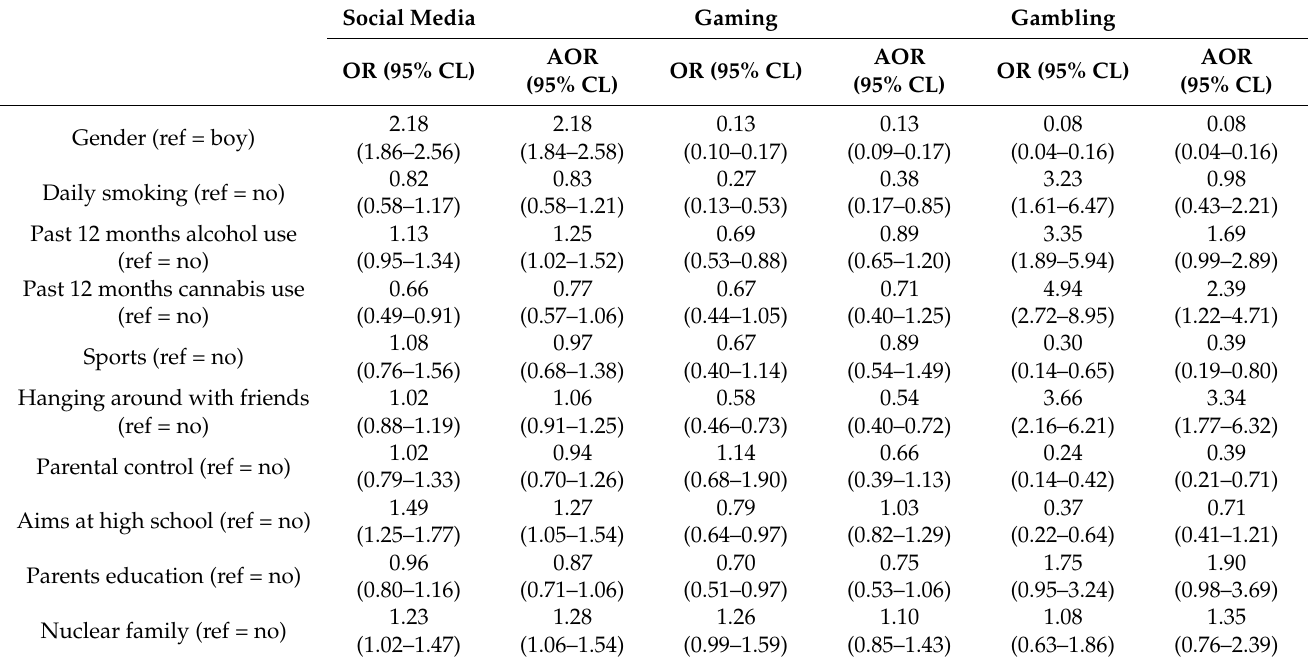
Table 2. Risk factors for excessive social media use, excessive gaming, and excessive gambling among Finnish 15–16 years old boys and girls in 2019, unadjusted (OR) and adjusted (AOR) odds ratios with 95% confidence levels